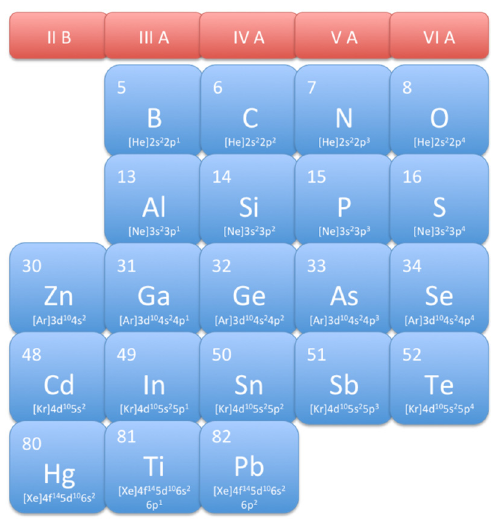
Figure 2. Table of elements involved in semiconductor based photodetectors (PDs) production.